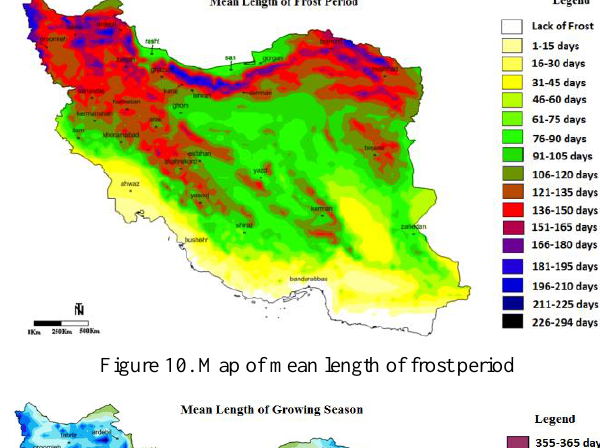
Figure 10. Map of mean length of frost period